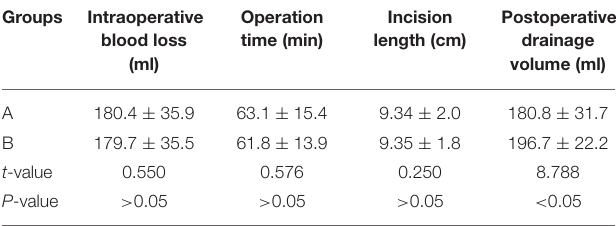
TABLE 1 | Comparison of surgical indicators between the two groups ( χ 2 ± S). Groups Intraoperative blood loss